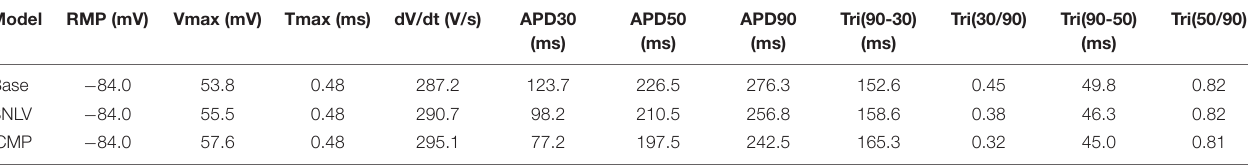
TABLE 3 | Action potential biomarkers for the base BOFC and derived SNLV and ICMP